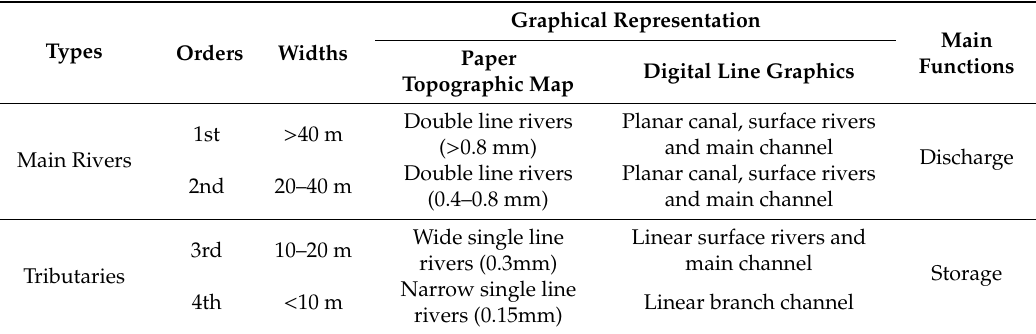
Table 1. Rivers classification in study